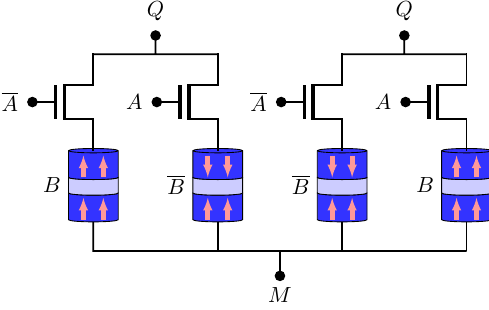
Figure 8. NV-XOR / NV-NXOR